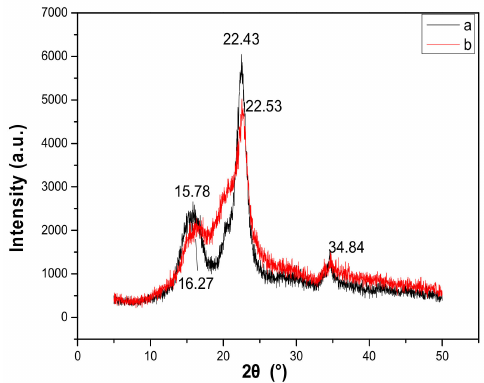
Figure4. XRDspectraofmicrocrystallinecellulose( a )andcellulosedissolvedinoxalicacidchlorocholine DES ( b ).